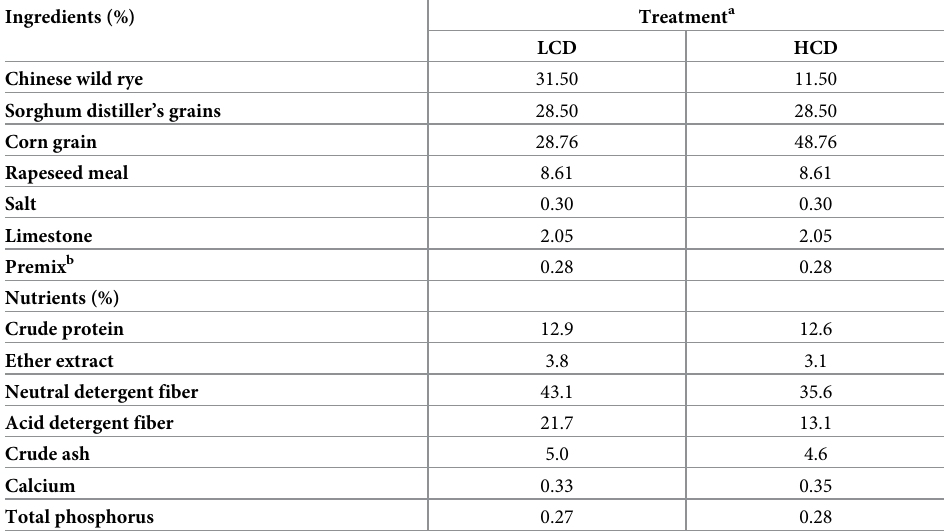
a LCD (the low-corn diet), the concentrate to roughage ratio was 40:60; HCD (the high-corn diet), the concentrate